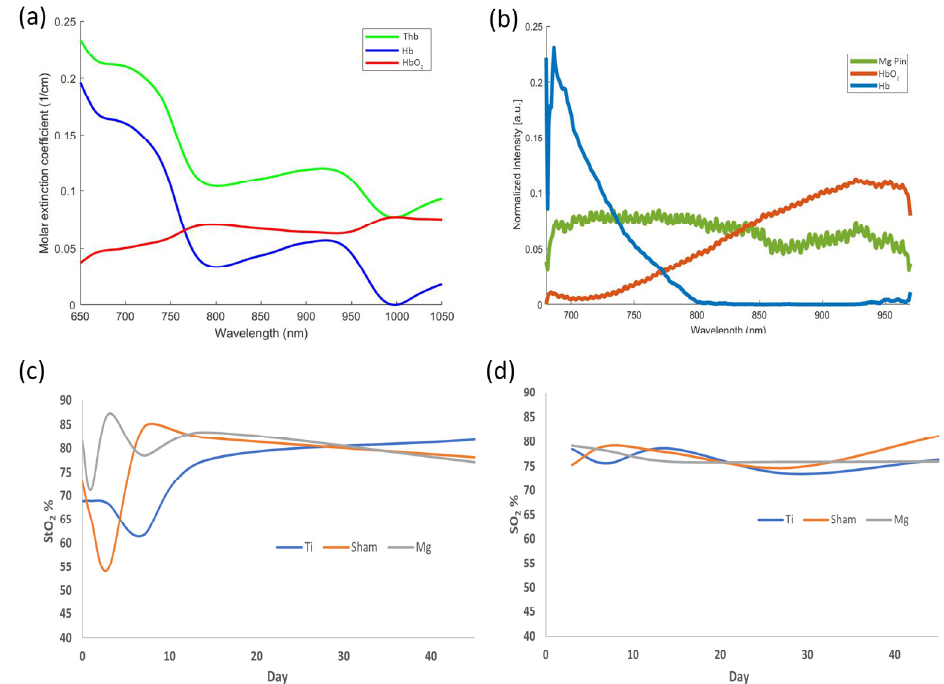
Figure 5. ( a ) The molar extinction coefficients of Hb, HbO 2 , and THb, as calculated from MBLL; ( b ) Unmixed spectra of the Hb, HbO 2 , and Mg implant pin after normalization; ( c , d ) Comparative analysis of oxygen saturation at the implant–tissue interface: ( c ) Near-infrared spectroscopy (NIRS); ( d ) Photoacoustic (PA) imaging.